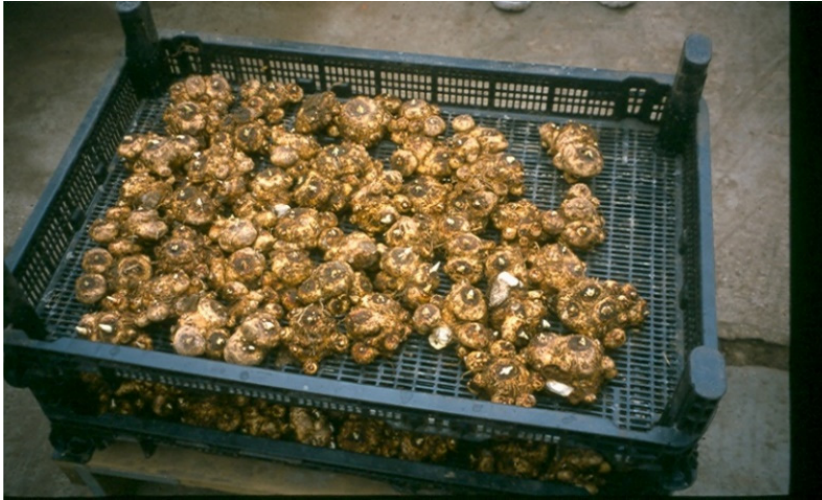
Figure 6 . Rhizomes in circumference with leaf buds (Beata Janowska 2010).